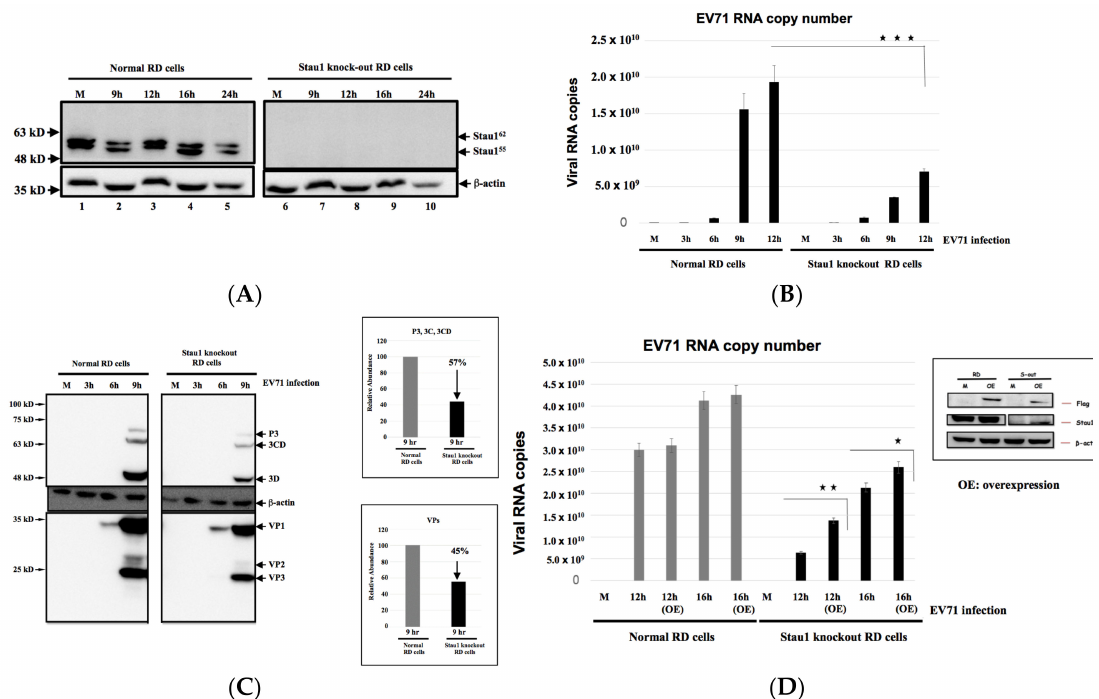
Figure 4. Reduction of EV-A71 viral RNA accumulation and viral protein production in the Stau1-knockout cells. ( A ) The Stau1 knockout cell line was generated using the CRISPR/Cas9 system as indicated in the Materials and Methods section. No expression of Stau1 was confirmed in the cells upon EV-A71 infection. ( B ) Reduction in EV-A71 viral RNA was determined using RT-qPCR analysis in the EV-A71-infected normal cells and Stau1 knockout cells. ( C ) Decreased production of EV-A71 viral proteins in the EV-A71-infected normal cells and Stau1 knockout cells. The right panels are the relative densities of protein bands measured using ImageJ software. ( D ) Ectopic expression of Stau1 restored the EV-A71 viral RNA accumulation in the Stau1 knockout cells. Overexpression of Flag-tagged Stau1 protein was detected during the Western blotting using anti-Flag- and anti-Stau1-specific antibodies in normal cells and Stau1 knockout cells (right panel). Star sign * indicates significant difference in comparisons * p < 0.05; ** p < 0.01; *** p < 0.001. OE: Overexpression; M: Transfection with plasmid